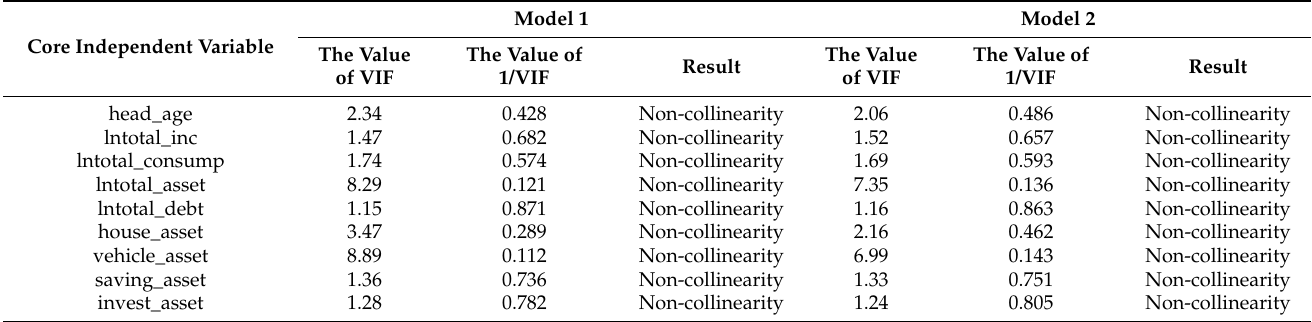
Table 4. Multicollinearity test results of the core independent variables.